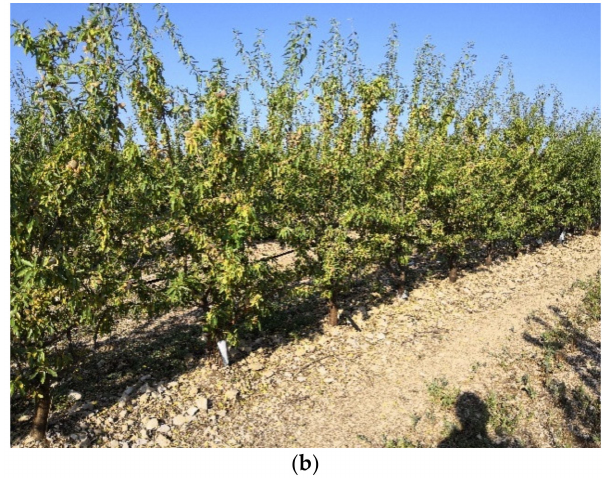
Figure 1. Guara Tuono ( a ) and Lauranne ® Avijour ( b ) trees in the experimental plots.